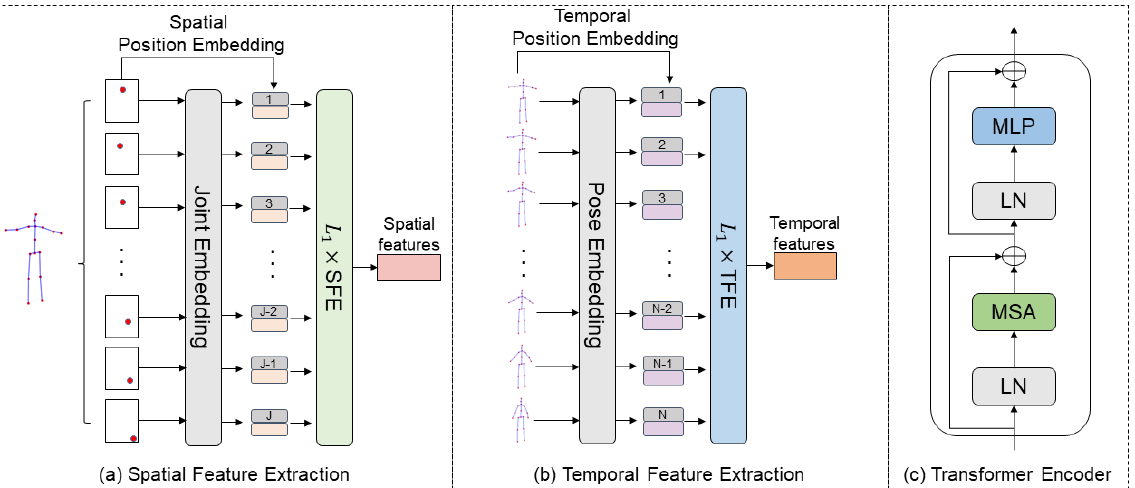
Figure 3. Feature Extraction module. ( a ) Within each frame, the Spatial Feature Extraction (SFE) branch is responsible for extracting information on the intrinsic structure of the body joints. ( b ) Tem- poral Feature Extraction (TFE) branch for learning the consistency relationships of the whole sequence. ( c ) The description of the Transformer encoder